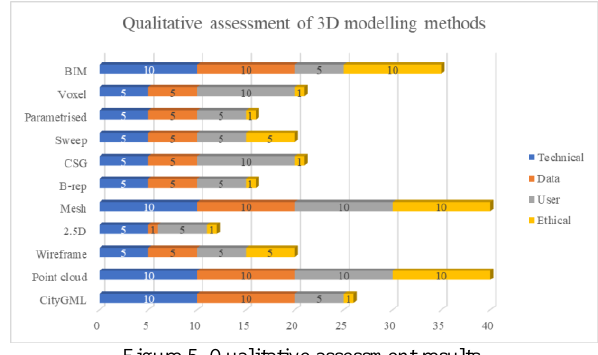
Figure 5. Qualitative assessment